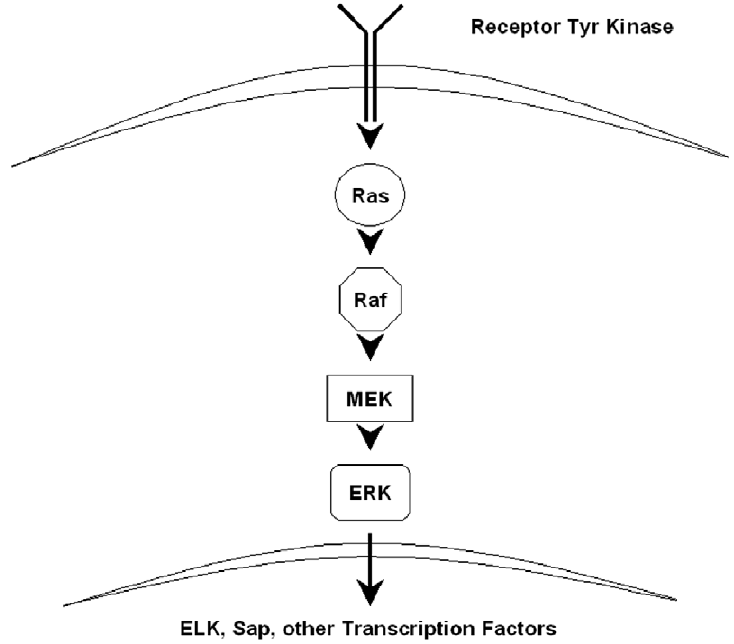
Fig. 1. Diagram of MAPK